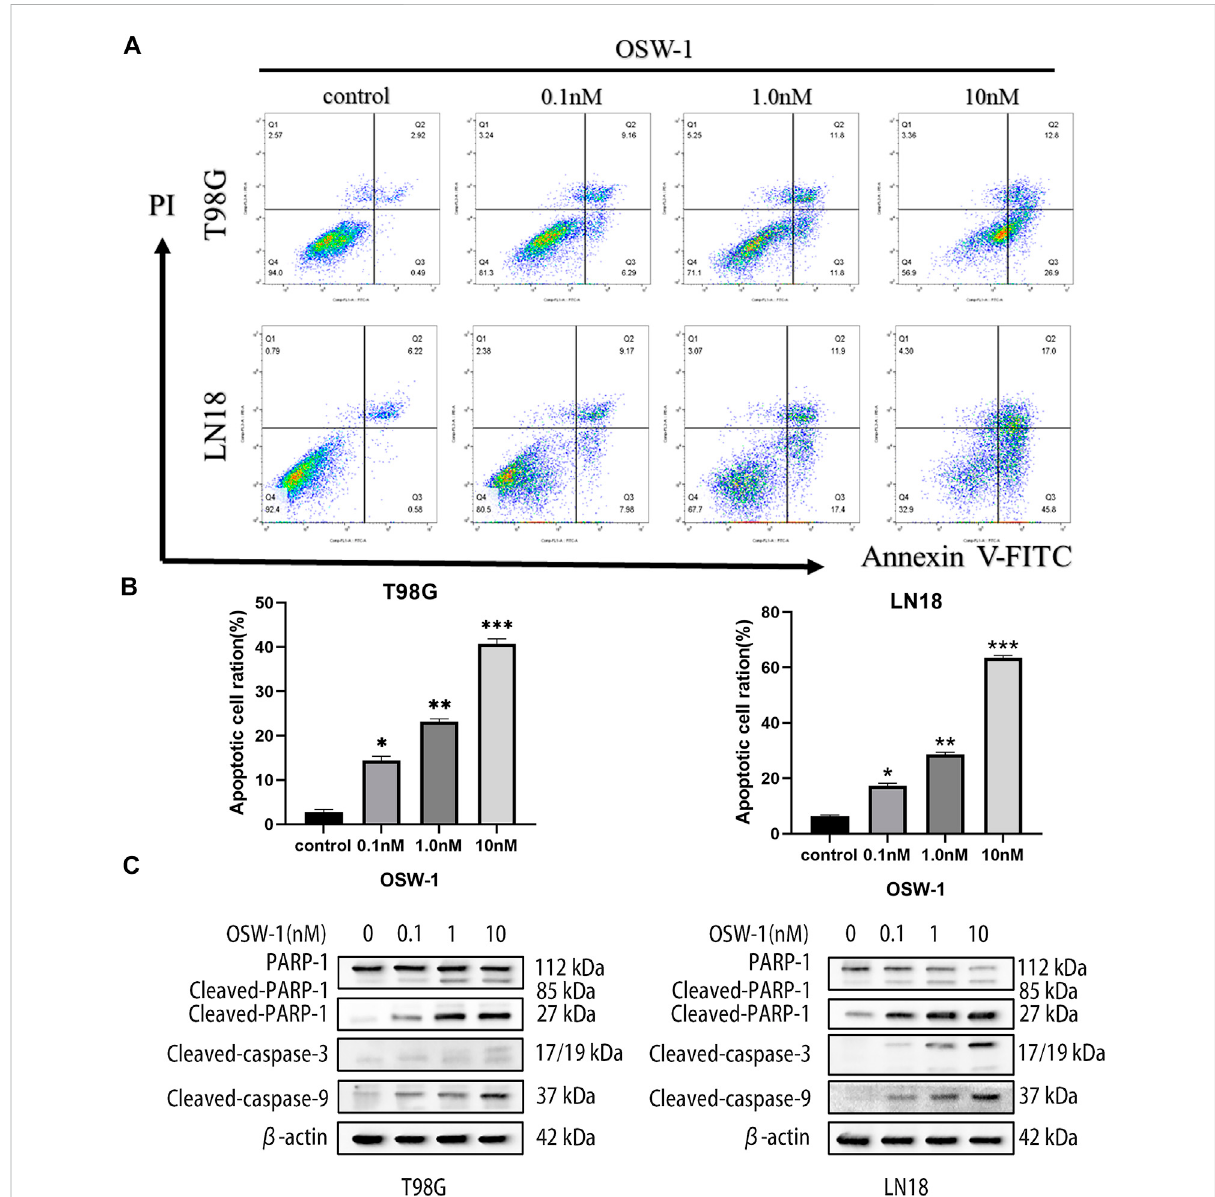
FIGURE 6 OSW-1 induced apoptosis in glioma cells (A) Flow cytometry was used to detected apoptosis of glioma cells treated with different concentrations of OSW-1 for 24 h, and results were analyzed using the FlowJo software (B) OSW-1 signi fi cantly increased the apoptotic cell ratio (Q2+Q3) of T98G and LN18 cells in a dose-dependent manner (C) Western blot shows the changes of apoptosis-related proteins after OSW-1 treatment for 24 h * p < 0.05, ** p < 0.01 and *** p < 0.001, compared to the control